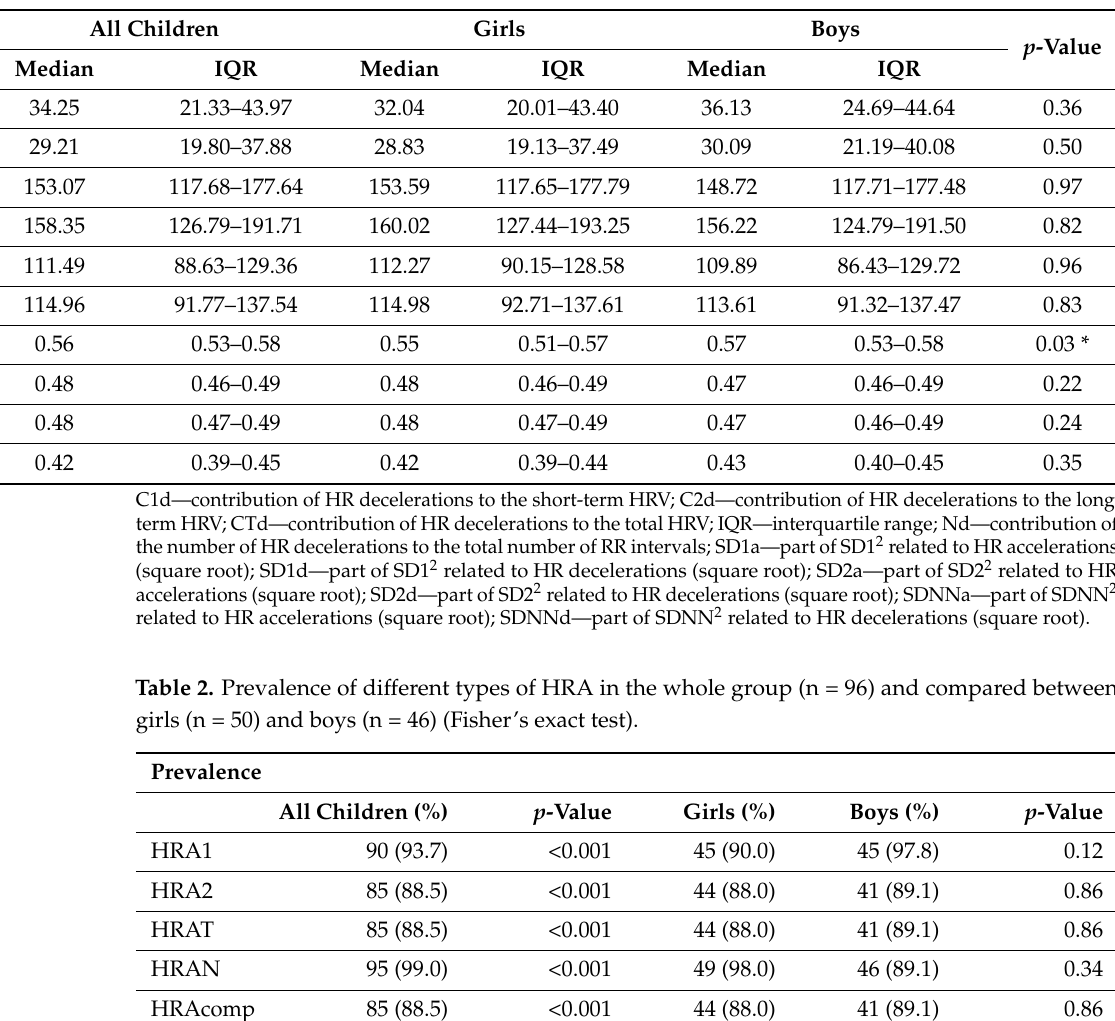
Table 1. HRA parameters in the whole group (n = 96) and compared between girls (n = 50) and boys (n = 46) (Mann–Whitney test; * p < 0.05).